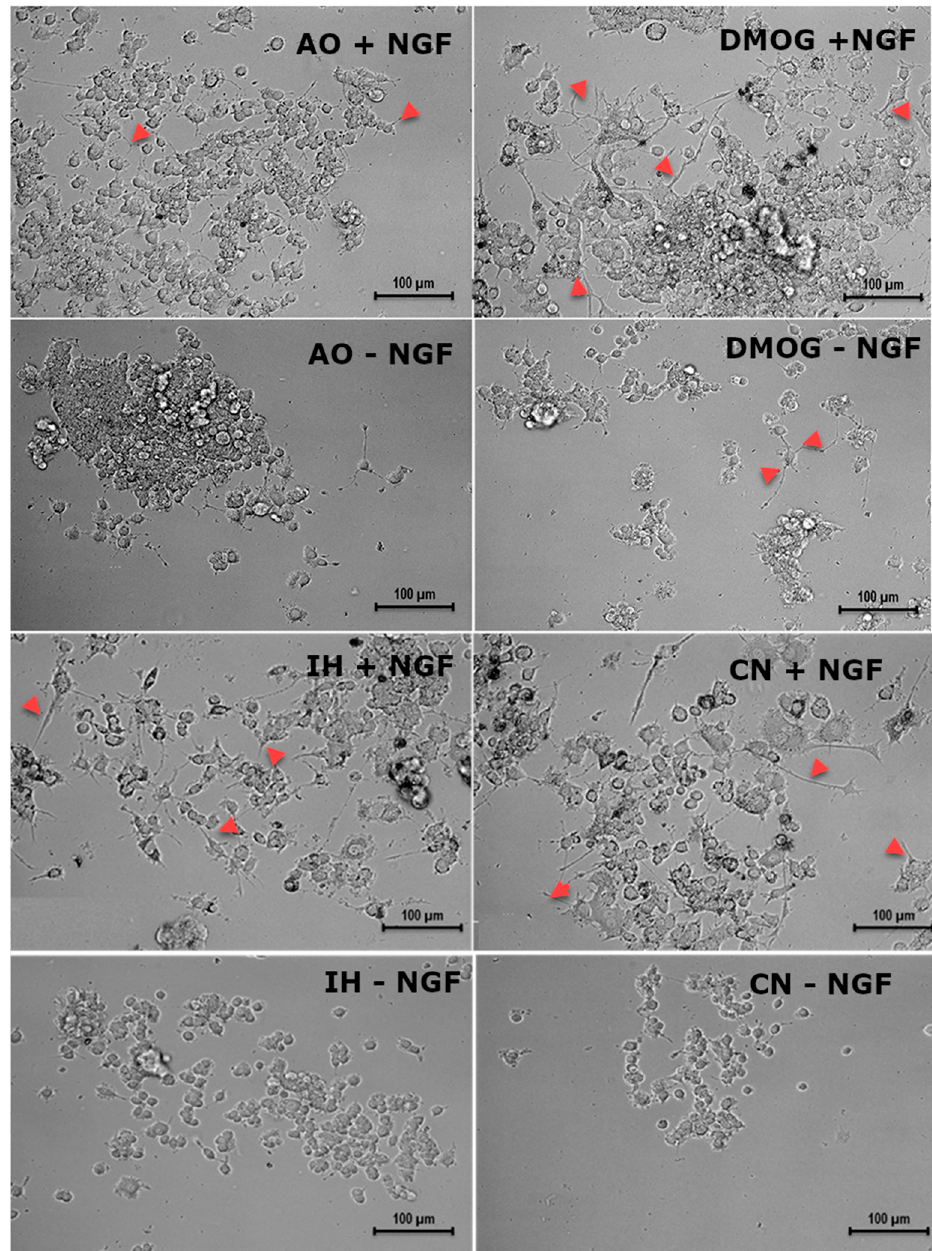
Figure 8. Representative images of PC12 cells at different oxygen levels and with DMOG, with or without nerve growth factor. PC12 cells were cultured in collagen IV precoated 24-well plates with and without nerve growth factor (NGF) stimulation for 7–10 days under three different oxygen culture conditions and with DMOG (0.1 mM). There was a significant increase in neurites with NGF treatment compared to cultures without NGF treatment, which had few neurites. On the other hand, DMOG also increased neurites under the air oxygen condition. The arrowheads indicate neurites. + NGF means with NGF; − NGF means without NGF. Scale bar indicates 100 µm.